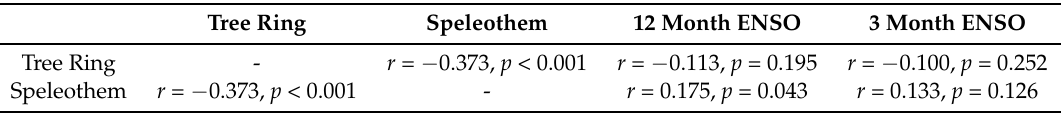
Table 1. Table detailing the results of Pearson’s correlation test between standardised tree ring width, δ 18 O in the speleothem sequence and 12- and 3-month ENSO values over the period 1871 to 2006. Tree Ring Speleothem 12 Month ENSO 3 Month ENSO Tree Ring - r = − 0.373, p < 0.001 r = − 0.113, p = 0.195 r = − 0.100, p = 0.252 Speleothem r = − 0.373, p < 0.001 - r = 0.175, p = 0.043 r = 0.133, p =